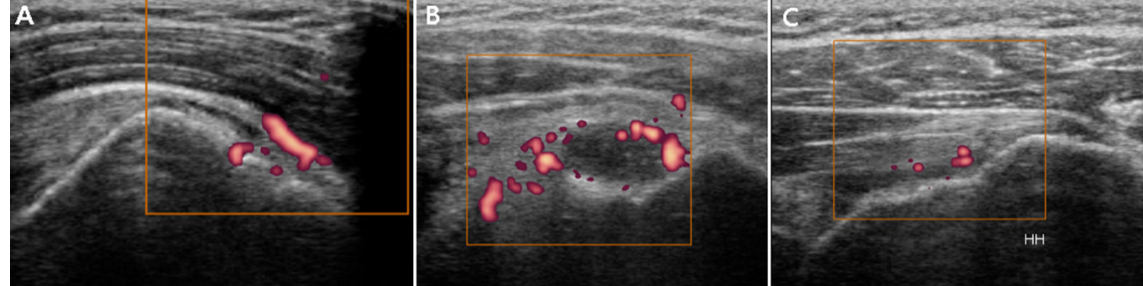
Figure 2. Illustrative power Doppler ultrasonography images. ( A ) Subacromial/subdeltoid bursitis, ( B ) long head biceps tenosynovitis , and ( C ) posterior glenohumeral synovitis. HH , humeral head.